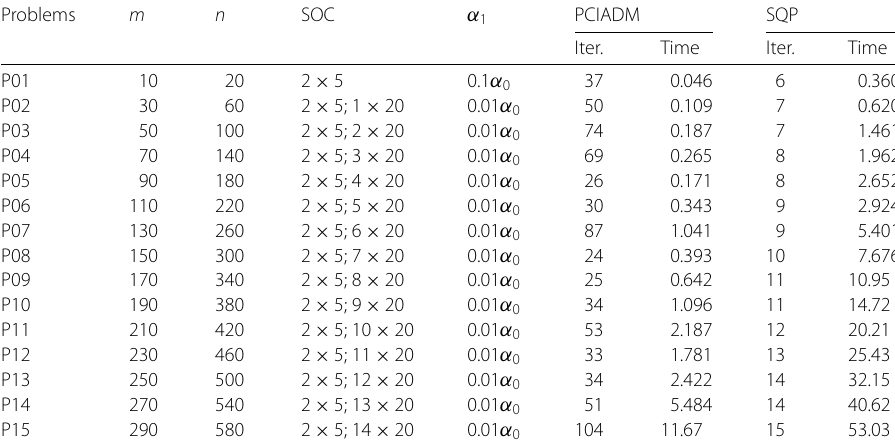
Table 1 The compared results for the test problems with medium scale